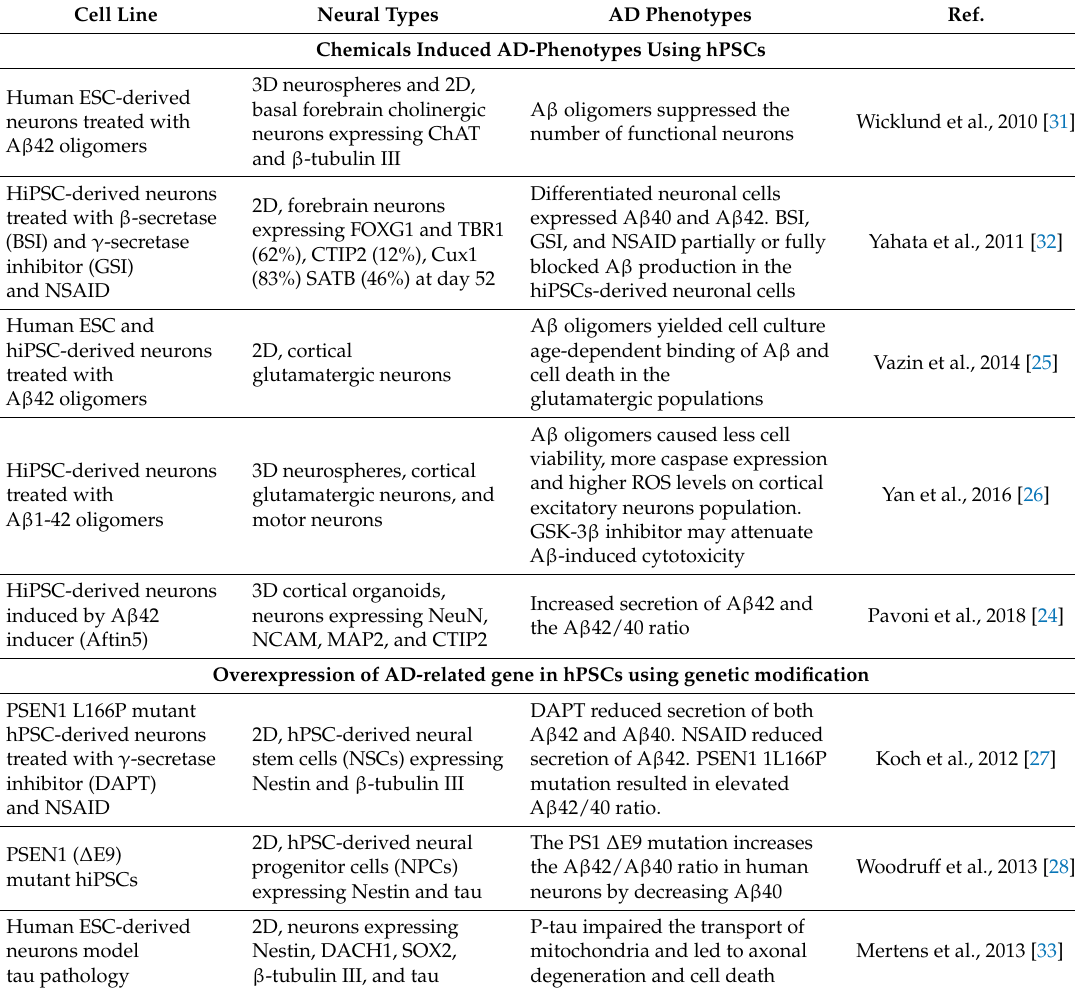
Table 1. Selected studies of hPSC-based models for Alzheimer’s